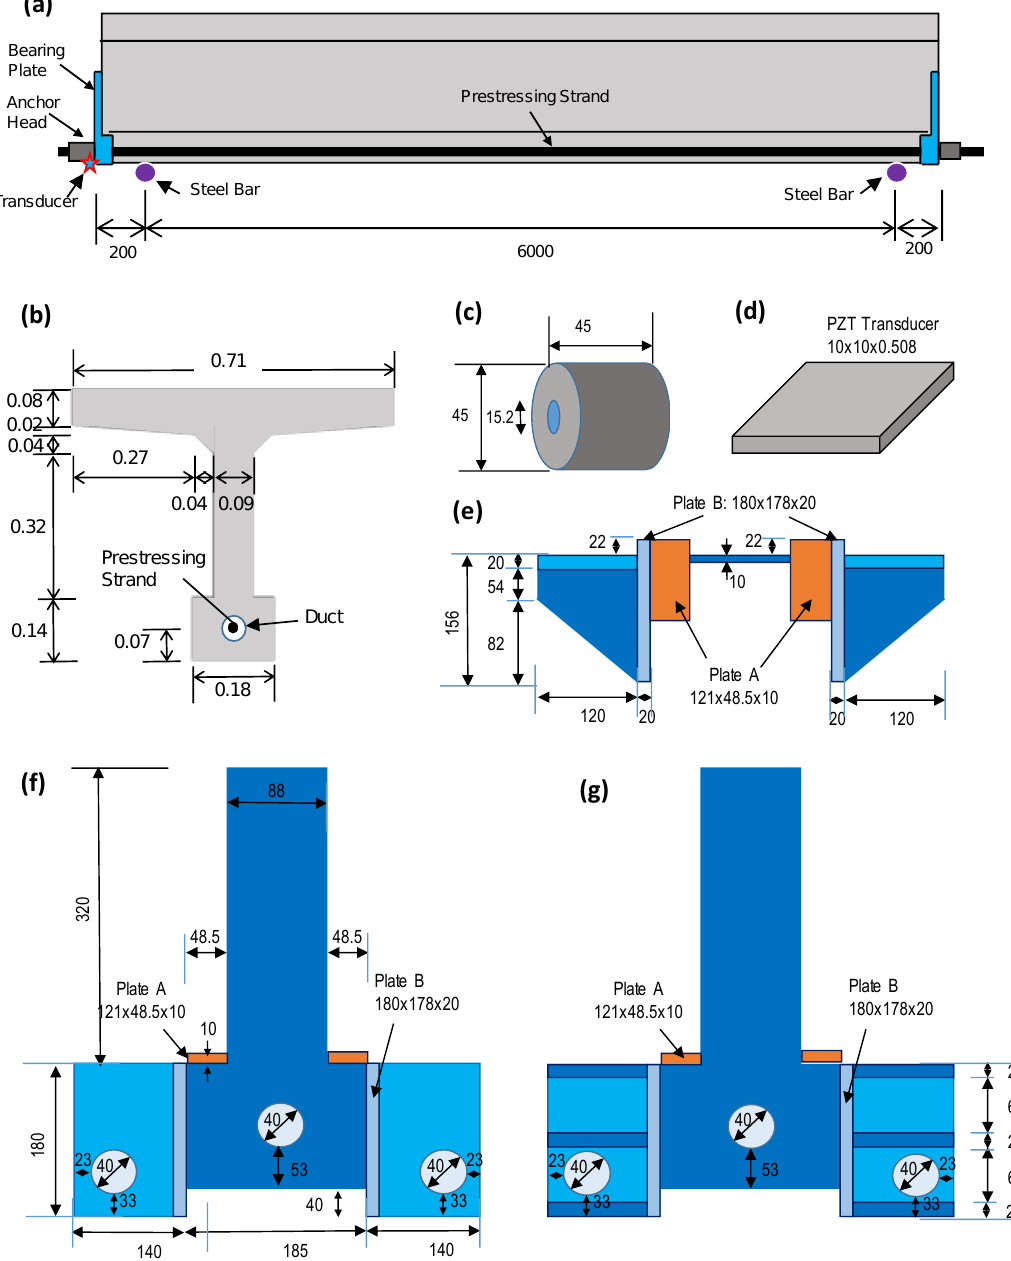
Figure 3. Geometry and dimensions of the target structure: ( a ) Prestressed RC beam; ( b ) cross-section of the beam; ( c ) anchor head; ( d ) PZT transducer; ( e ) top view, ( f ) front view and ( g ) back view of the bearing plate.